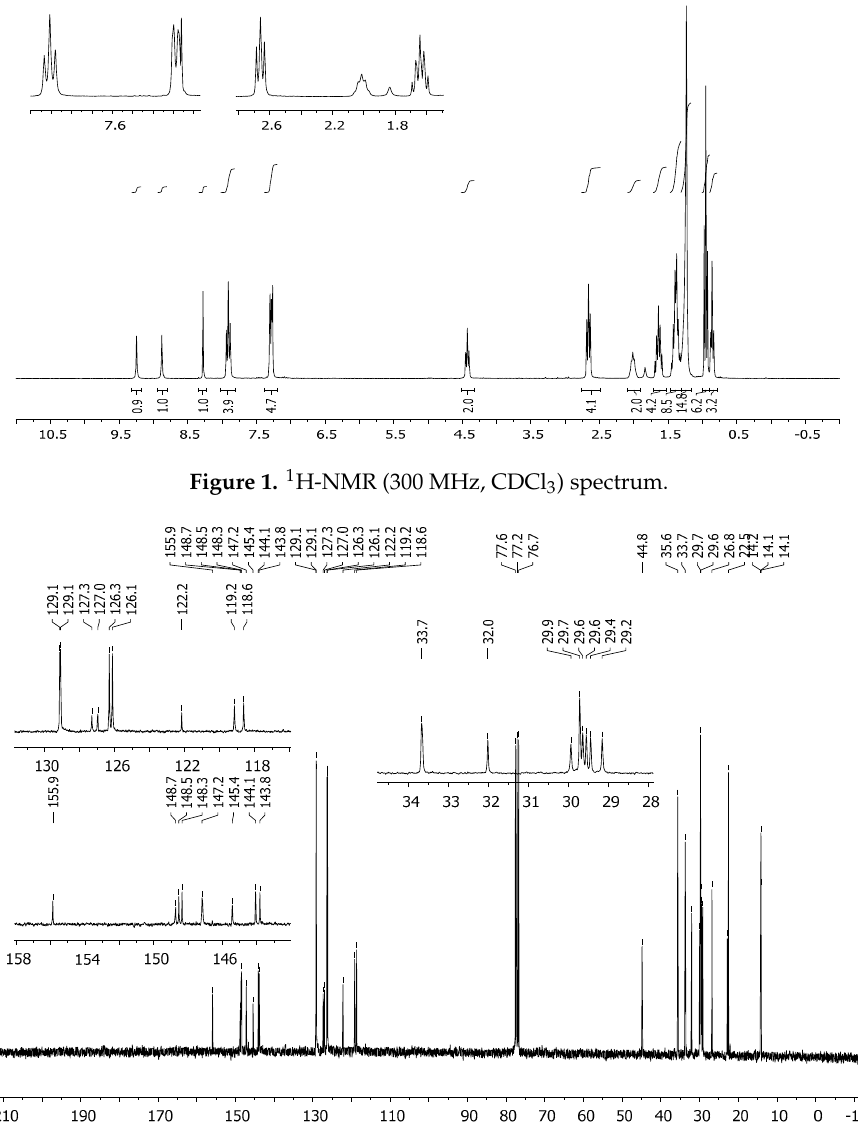
Figure 2. 13 C-NMR (75.5 MHz, CDCl 3 ) spectrum.